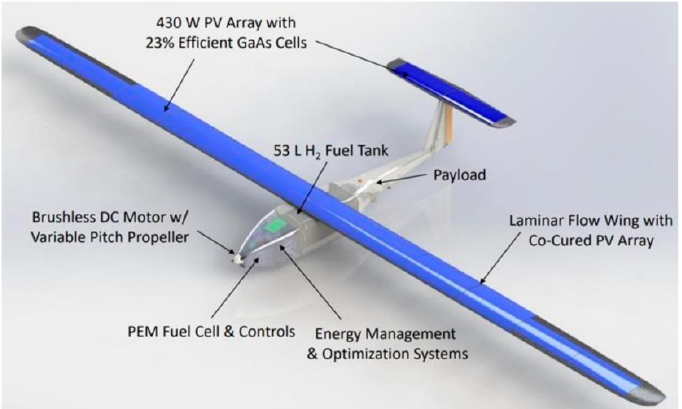
Figure 2. Fuel cell unmanned vehicle [25]. Republished with permission from Elsevier (License no: 5416380516416).